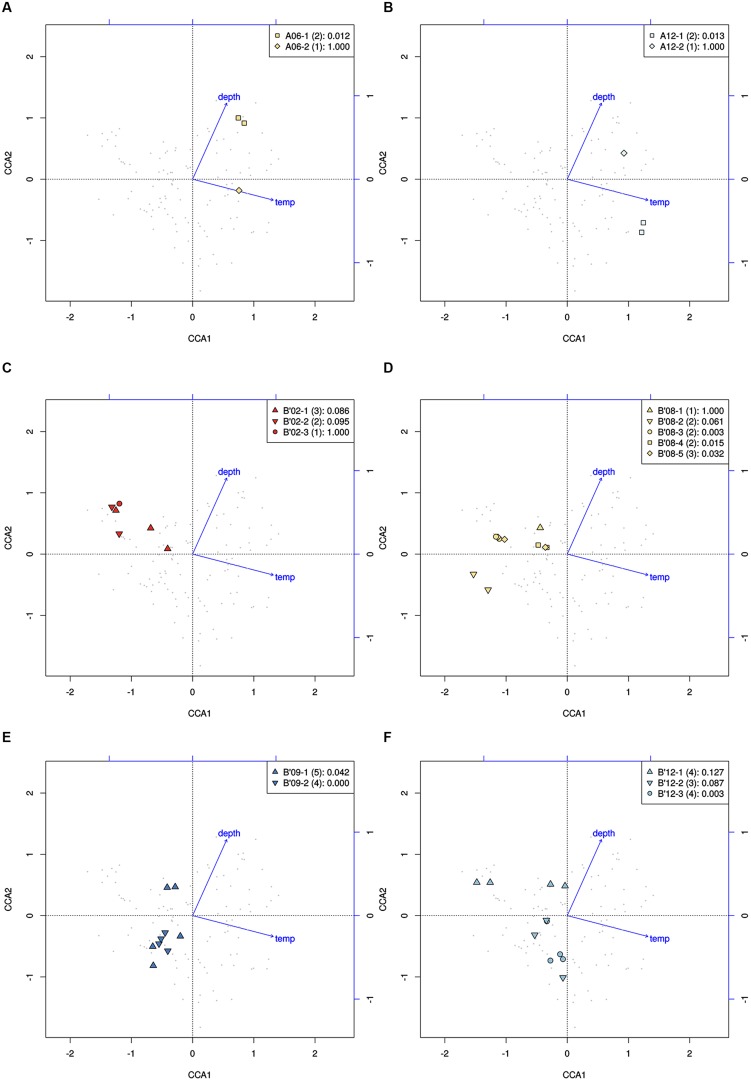
Canonical correspondence analyses of high-frequency psaA sequence variants predicted by Ecotype Simulation to belong to the same PE. (A,B) Clustering of predominant variants (squares) to the exclusion of the least abundant variant (diamonds) within A-like PEs demarcated using the fine-scale approach. (C–F) Clustering of variants within PEs demarcated by the fine-scale approach (different symbols) that were demarcated as a single PE by the conservative approach (all points). Legends indicate how symbols correlate with PEs shown in Figure 1 and include the p-value associated with the cluster being different from random.